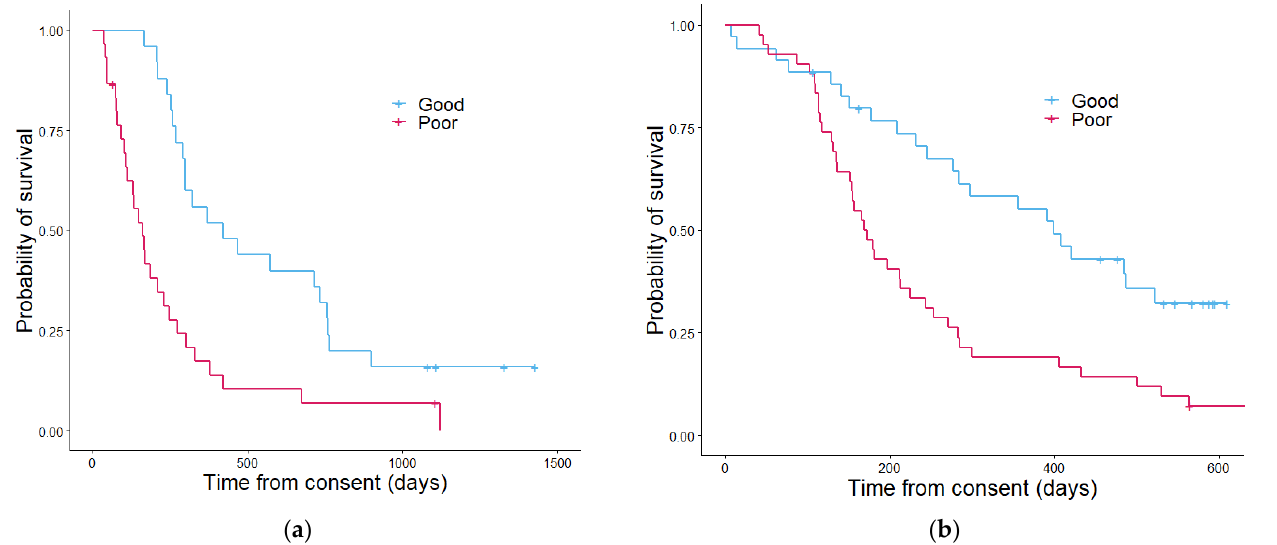
Figure 4. Kaplan–Meier curves showing the overall survival determined by the Wellness Score in the discovery cohort ( a ) and the validation cohort ( b ). In the discovery cohort ( a ) patients with a good outcome Wellness Score had a median overall survival of 422 days and patients with a poor outcome Wellness Score had a median overall survival of 161 days. The p value was 5.5 × 10 45 . In the validation cohort ( b ) the median overall survival estimate in days for patients with a good outcome Wellness Score was 407 and 167 for patients with a poor outcome Wellness Score. The p value was 4.5 × 10 − 4 .